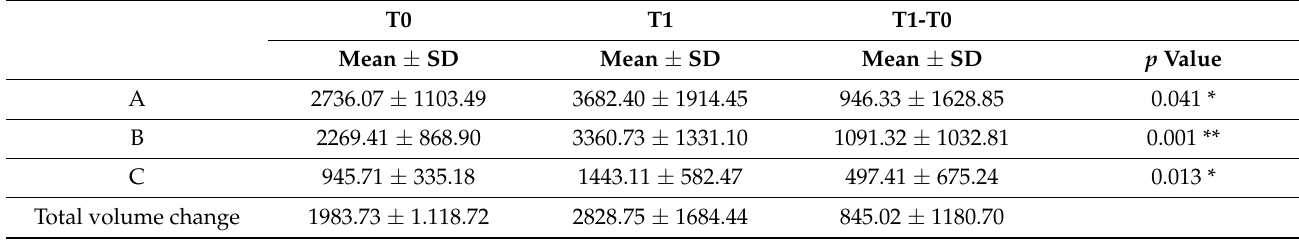
Table 4. Changes in Pharyngeal Airway Volume (mm 3 ) as analyzed in 3D Models.